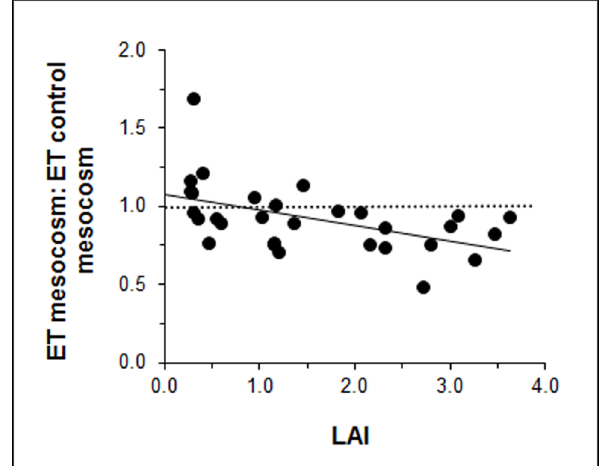
Figure 4. Relationship between plot-LAI and mesocosm evapotranspiration (ET) for the summers of 2008, 2009 and 2010. ET of the mesocosms with trees (LT and HT) were averaged over the summer (period V) for each year separately and standardized by dividing by the ET from mesocosms without trees (NT mesocosms). Symbols above the dashed line indicate a higher evapotranspiration than NT mesocosms, whereas symbols below this line indicate lower evapotranspiration than NT mesocosms. The solid line indicates a weak, but significant, ( P , 0.05), linear relationship (linear regression, R 2 =0.25, y=0.1x + 1.1).